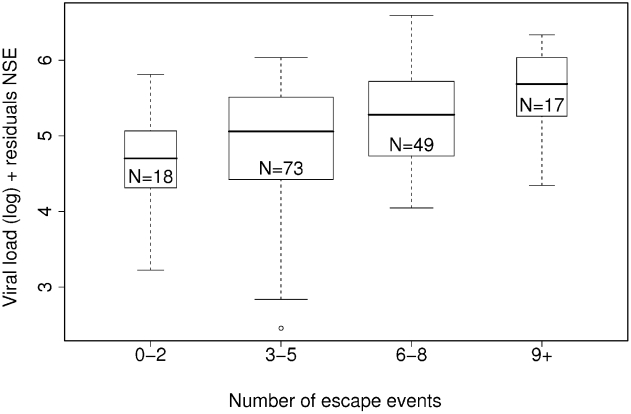
The number of escaped events (NEE) against log viral load, corrected for the number of synonymous epitopes (NSE).Number of escape events is a significant predictor of log viral load after the background level of mutation is taken into account (multiple linear regression: p = 0.0021, gradient = 0.11, r2 = 0.060, N = 157). The width of each bar is proportional to the number of points. Alternate representations of this data are shown in Figure S2.